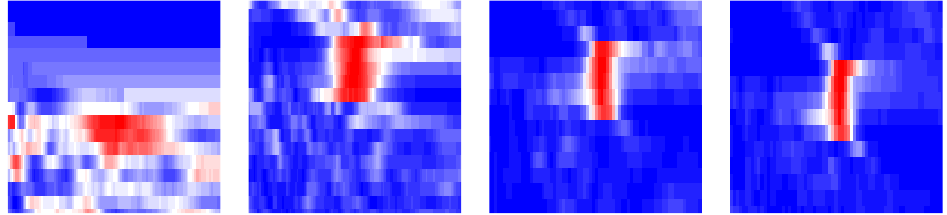
Figure 8. Examples of negative sample.